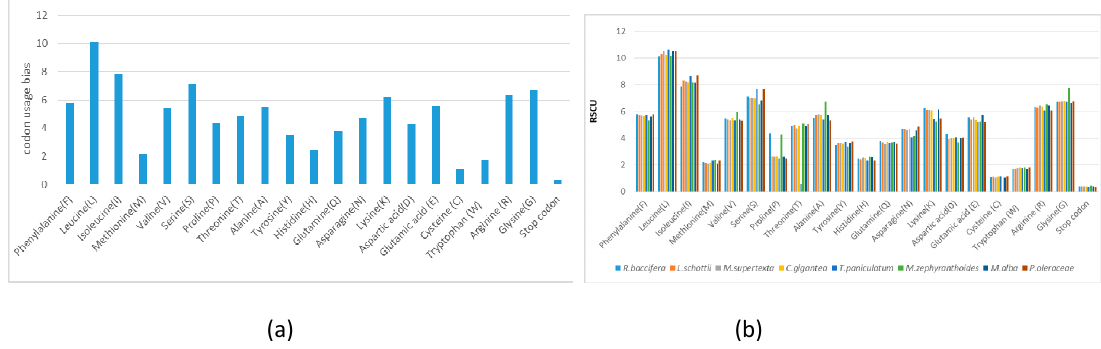
Figure 5. Amino acid composition of proteins coded by the chloroplast genome of R. baccifera ( a ) and members of the Portulacineae ( b ).